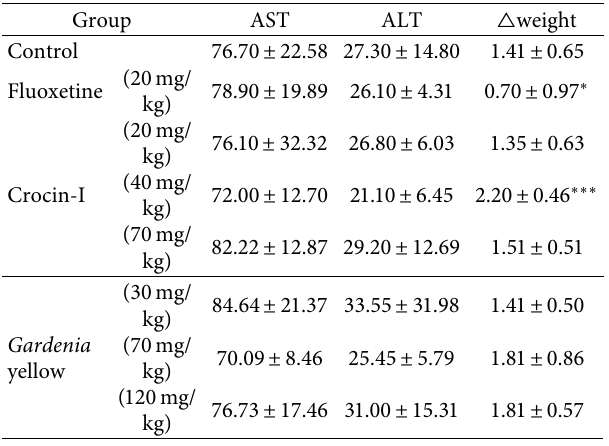
Table 4: Effects of crocin-I (20, 40, and 70 mg/kg, i.g.) and Gar- denia yellow (30, 70, and 120mg/kg, i.g.) on the weight, AST, and ALT of mice ( X ±